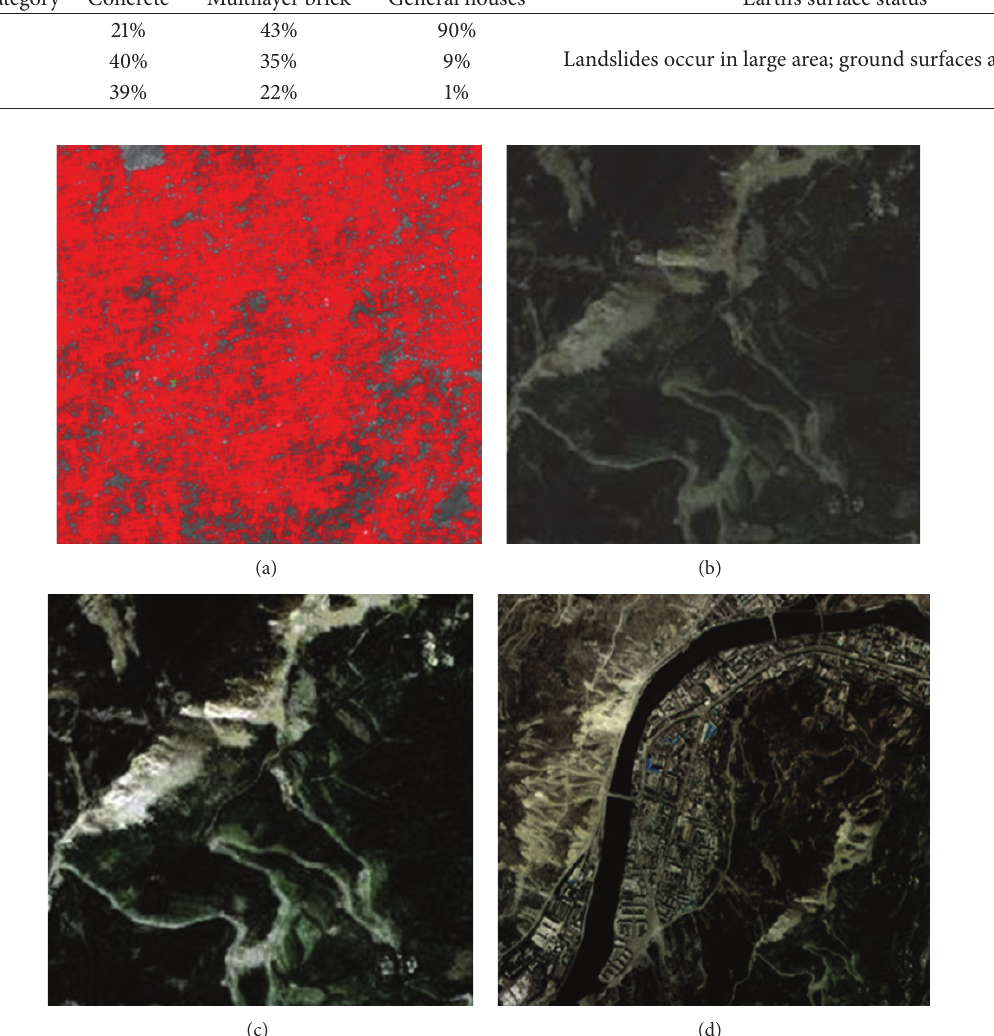
Figure 2: (a) Result image of automatic control point matching; (b) original image before enhancement; (c) Image after enhancement; (d) image after